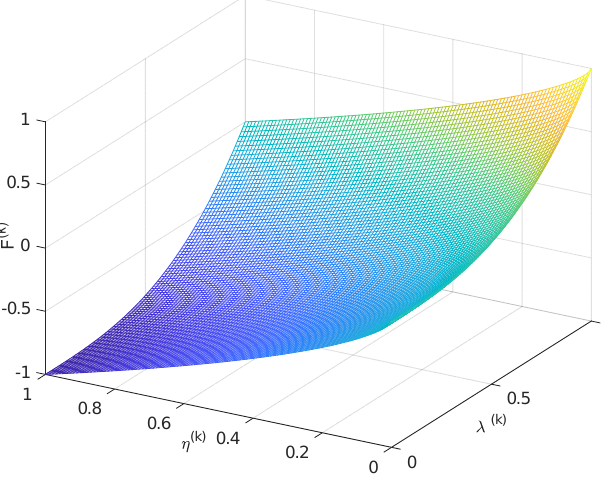
Figure 3. Relationship between values of F k , α and β